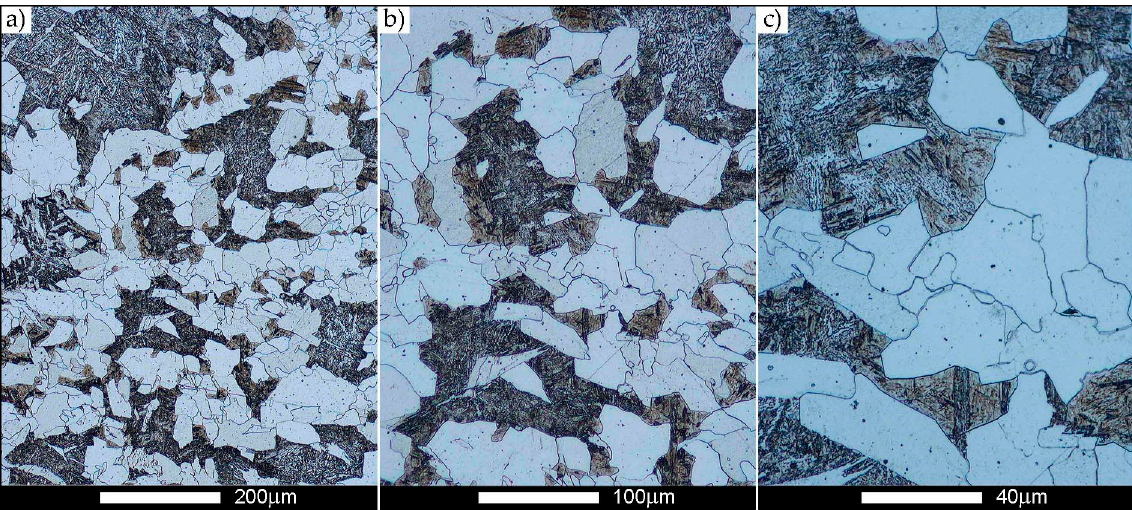
Figure 33. Welded joint microstructure of Hardox 450 steel with visible grain boundaries of prior austenite, austenitised at 1100 °C—WM1 zone shown in Figure 2. ( a ) 100×; ( b ) 200×; ( c ) 500×.